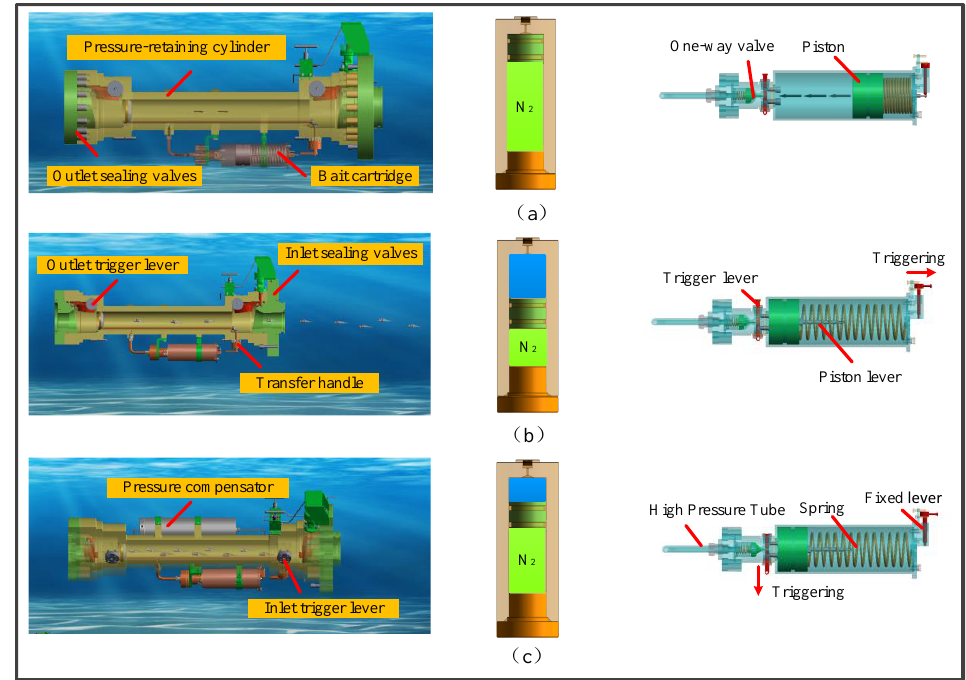
Figure 3. Working principle of HSMPS. ( a ) Lowering; ( b ) Sampling ; ( c ) Recycling